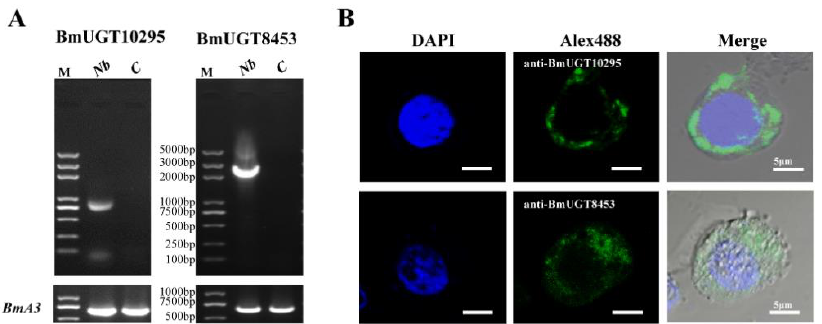
Figure 5. BmUGTs induced by Nosema bombycis in the infected BmN-SWU1 cell line. ( A ): RT-PCR showed that the BmUGT expression was activated by N. bombycis (Nb) in the infected cell line but not in control. Bombyx mori actin3 (BmA3) was the internal reference. ( B ): Localization of BmUGTs in the infected BmN-SWU1 cell line. Green fluorescence was observed in the samples incubated with the polyclonal antibodies of BmUGTs. Blue fluorescence represents nuclei labeled with DAPI (Sigma, Saint Louis, MO, USA).